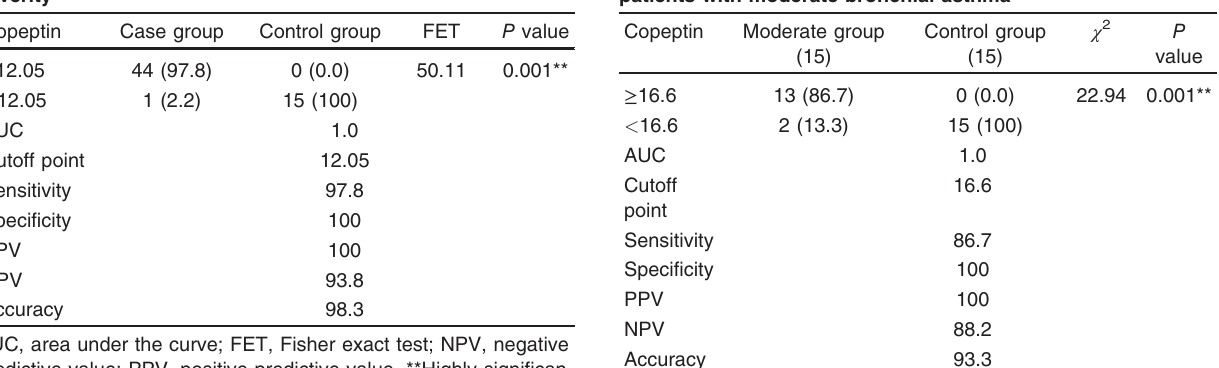
Table 13 Validity of copeptin as a predictor of disease among patients with moderate bronchial asthma